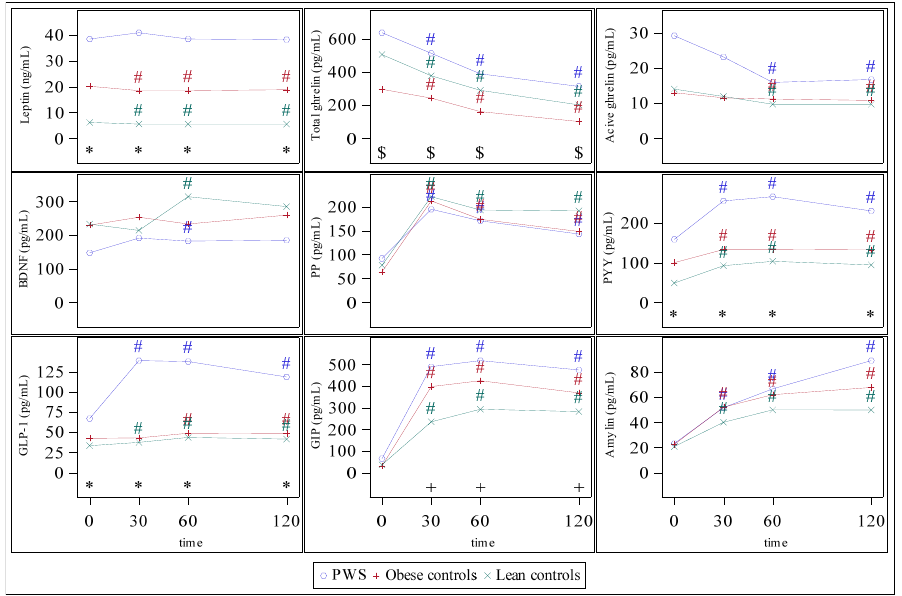
Figure 1. Postprandial hormonal concentrations. # p < 0.05 vs. basal concentrations. * p < 0.05 between groups. $ p < 0.05 PWS vs. obese controls. + p < 0.005 PWS vs. lean controls. Plasma brain ‐ derived neurotrophic factor (BDNF), peptide YY (PYY), pancreatic polypeptide (PP), Glucagon ‐ like peptide ‐ 1 (GLP ‐ 1), glucose ‐ dependent insulinotropic polypeptide (GIP) .